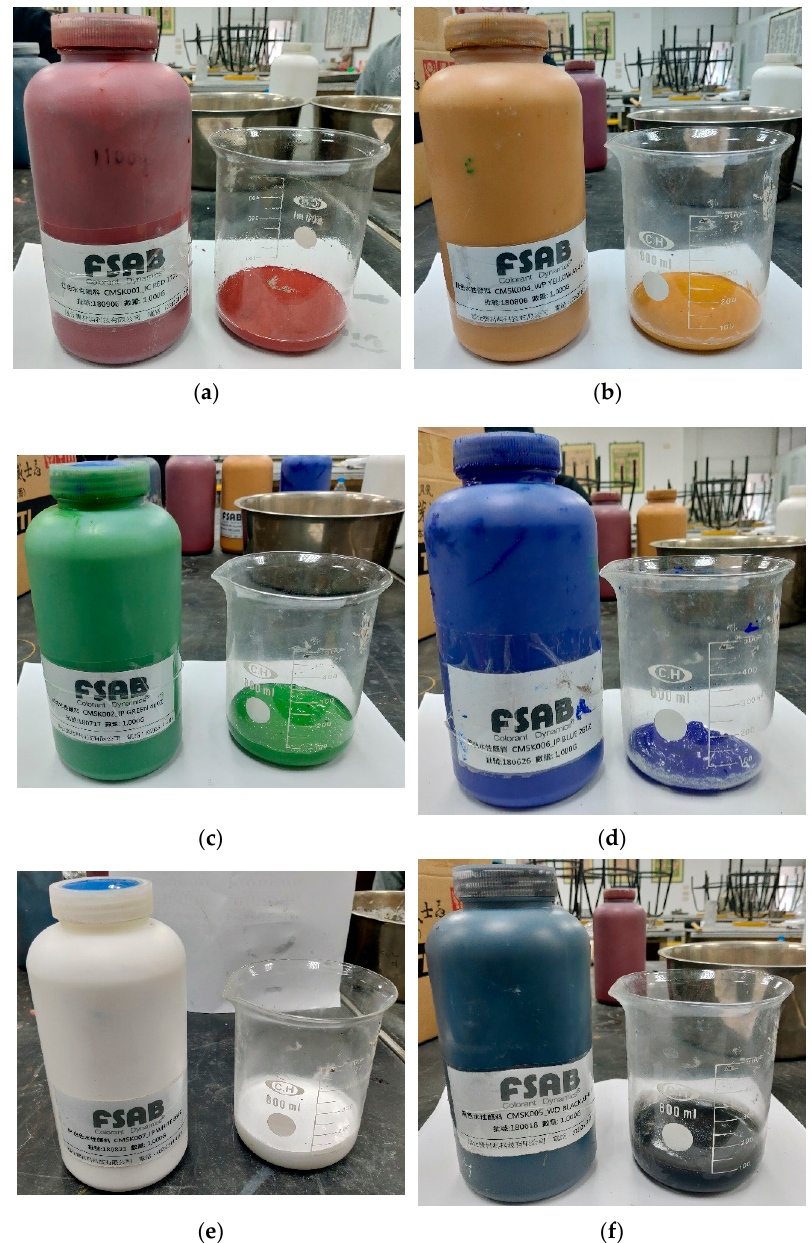
Figure 2. Experiment material—inorganic color paste. ( a ) red inorganic color paste; ( b ) yellow inorganic color paste; ( c ) green inorganic color paste; ( d ) blue inorganic color paste; ( e ) white inorganic color paste; ( f ) black inorganic color paste.